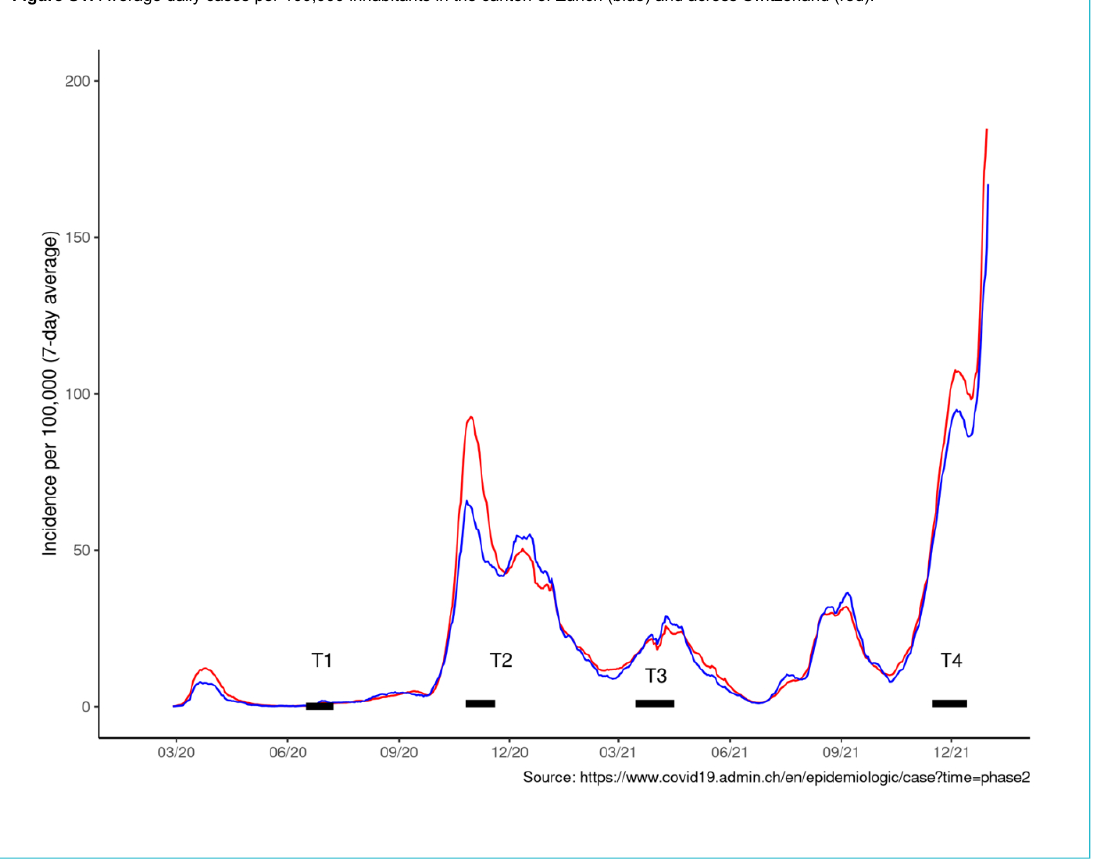
Figure S1: Average daily cases per 100,000 inhabitants in the canton of Zurich (blue) and across Switzerland